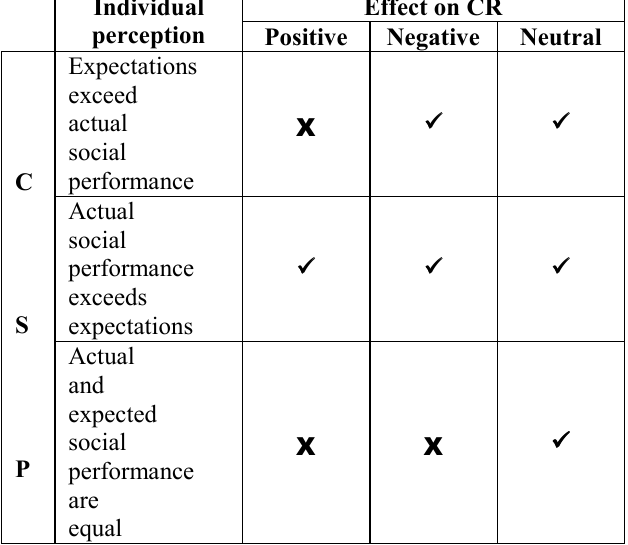
Effect on CR Individual